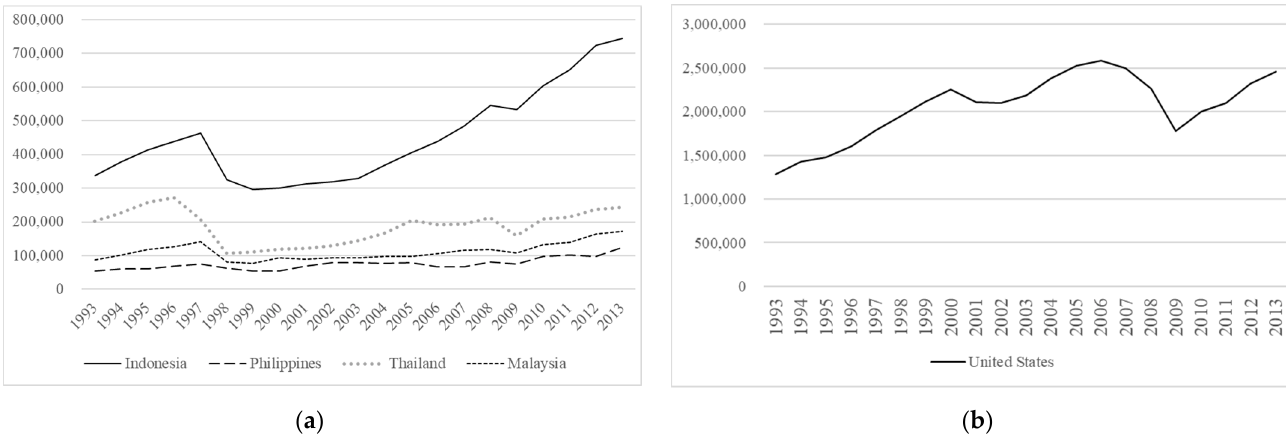
Figure 3. ( a ) Real Fixed Asset Investment (Unit: the US $1 Billion), sourced by Economist Intelligence Unit (EIU) country data; ( b ) Real Fixed Asset Investment (Unit: the US $1 Billion), sourced by EIU country data.